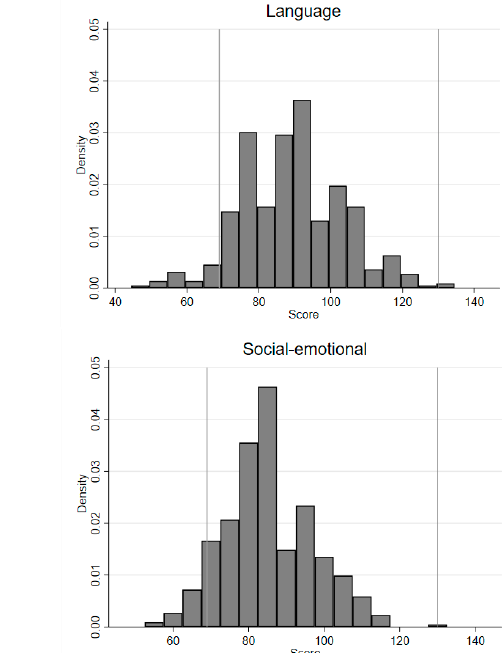
Figure 1. Density distribution of BSID-III composite scores.